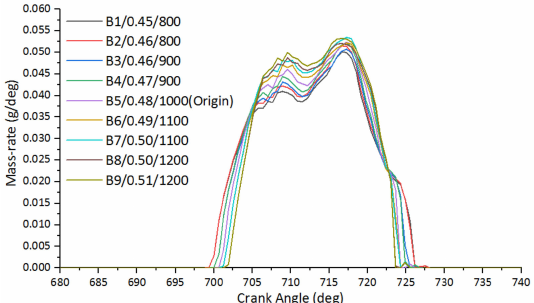
Figure 26. Fuel injection rate for Pre-selection schemes.